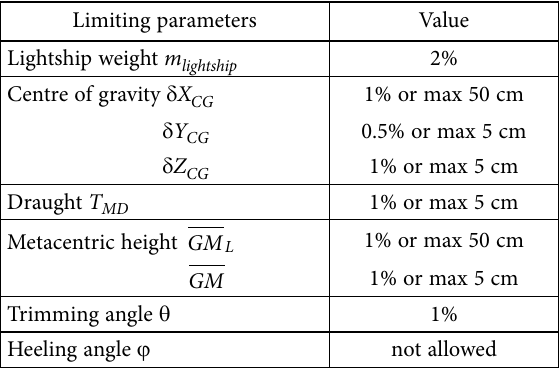
Table. Main acceptable tolerances (IACS 2016) Limiting parameters